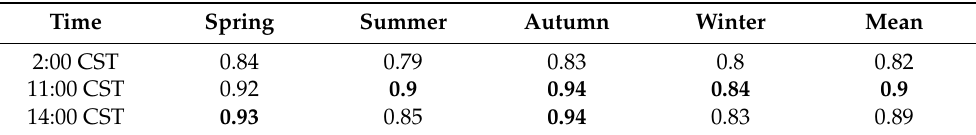
Table 5. Correlation coefficients between daily measured PM 2.5 and hourly measured PM 2.5 at satellite overpass time: 2:00 CST, 11:00 CST, and 14:00 CST represent the transit time of NPP, Terra, and Aqua, respectively, which are commonly used to estimate PM 2.5